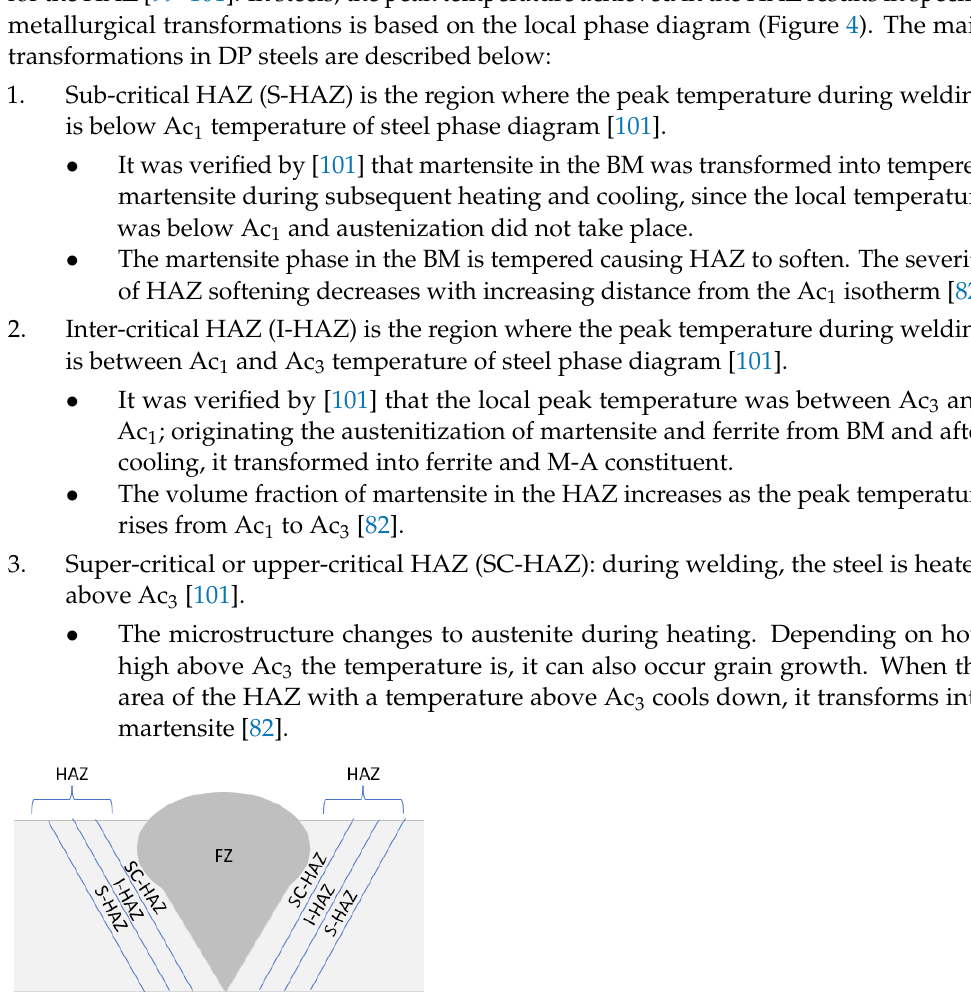
Figure 4. HAZ areas [102].